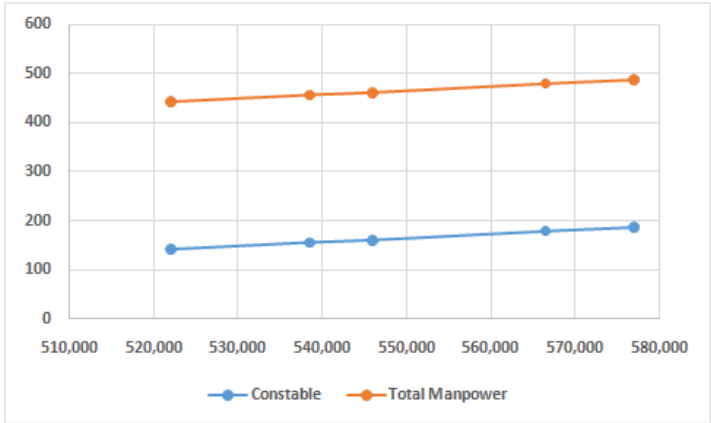
Figure 4. Number of Constables and total manpower allocation with increasing cost of